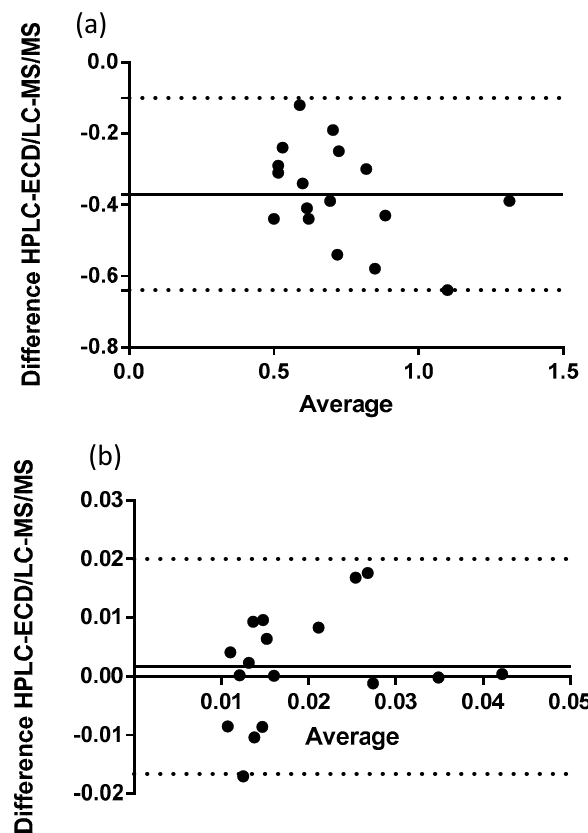
Figure 6. ( a ) Bland–Altman plot of ubiquinol ( N = 17) and ( b ) Bland–Altman plot of ubiquinone ( N = 17). The continuous line is the bias. The dotted lines are the 95% limits of agreement.